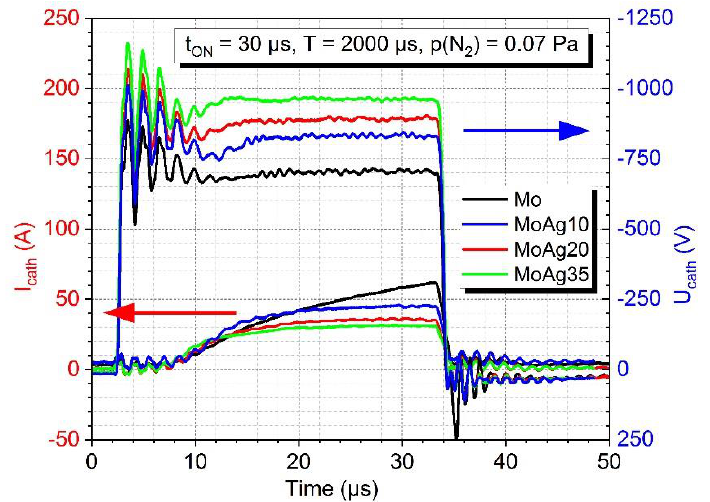
Figure 2. Cathode voltage and current for the HiPIMS pulse with 30 µs t ON and a pulse duration of 2000 µs for Mo and the 3 different MoAg targets.